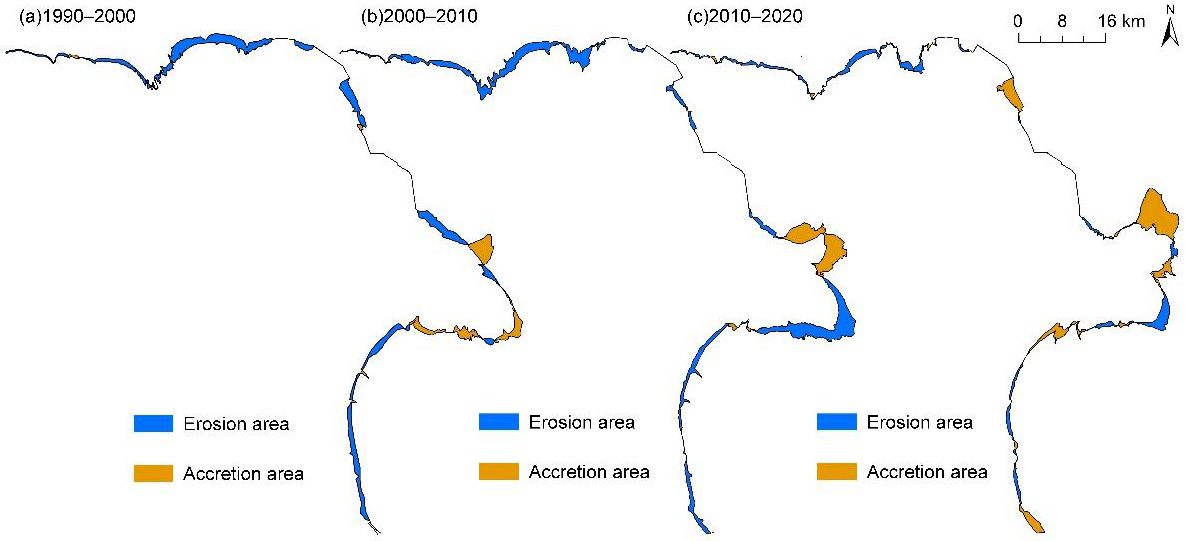
Figure 4. The erosion and accretion area along the YRD coast during different periods.